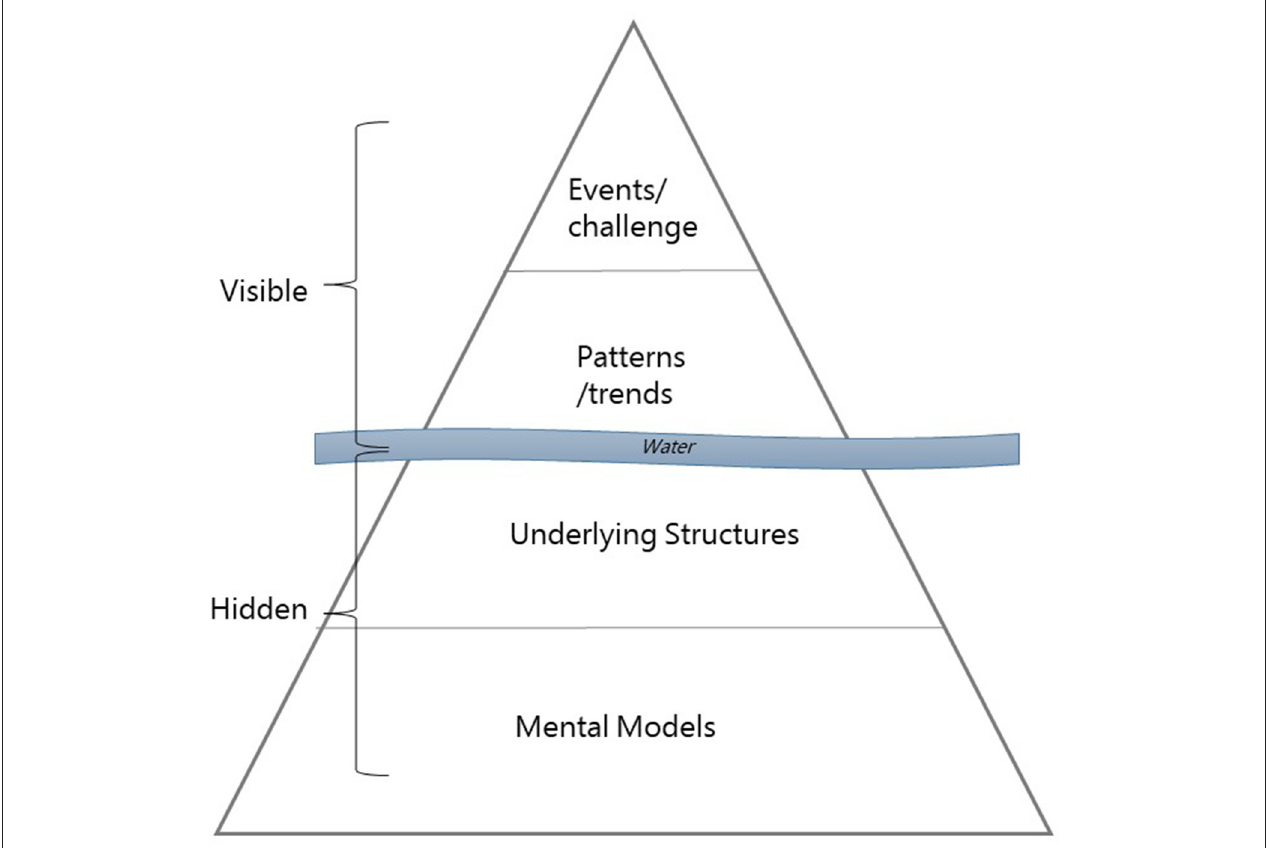
FIGURE 2 | The iceberg model of a human-designed system. The model consists of two visible components above the water surface and two hidden components beneath the water surface. Repeated events demolish the patterns of the system, which are influenced by system structures. Mental models are people’s behavior that is shaped by the system structures. Drawing inspired by